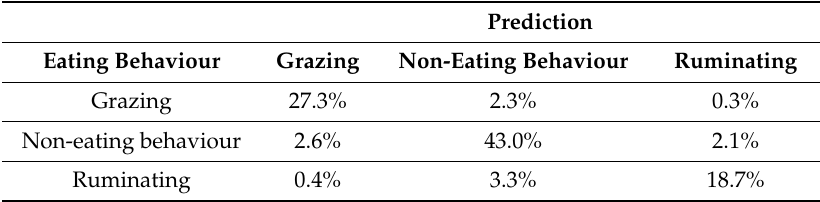
Table 7. Confusion matrix using ear data and 39 features to assess the performance of classification of specific eating behavioural activities based on random forest.